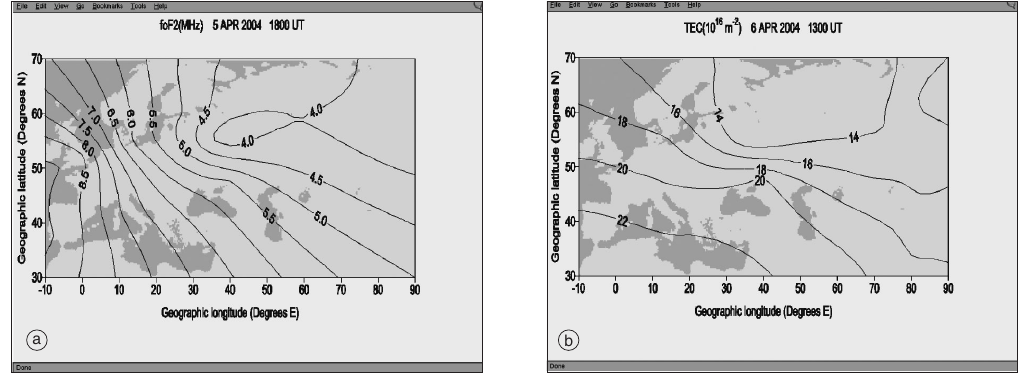
Fig. 3.2a,b. Example maps from the web site of the STIF tool at RAL. a) Forecast of foF 2 1 h ahead; b) fore- cast of derived TEC 20 h